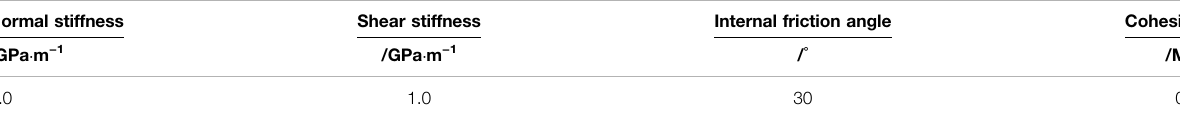
TABLE 3 | Physical mechanics parameters of the fault interface. Normal stiffness Shear